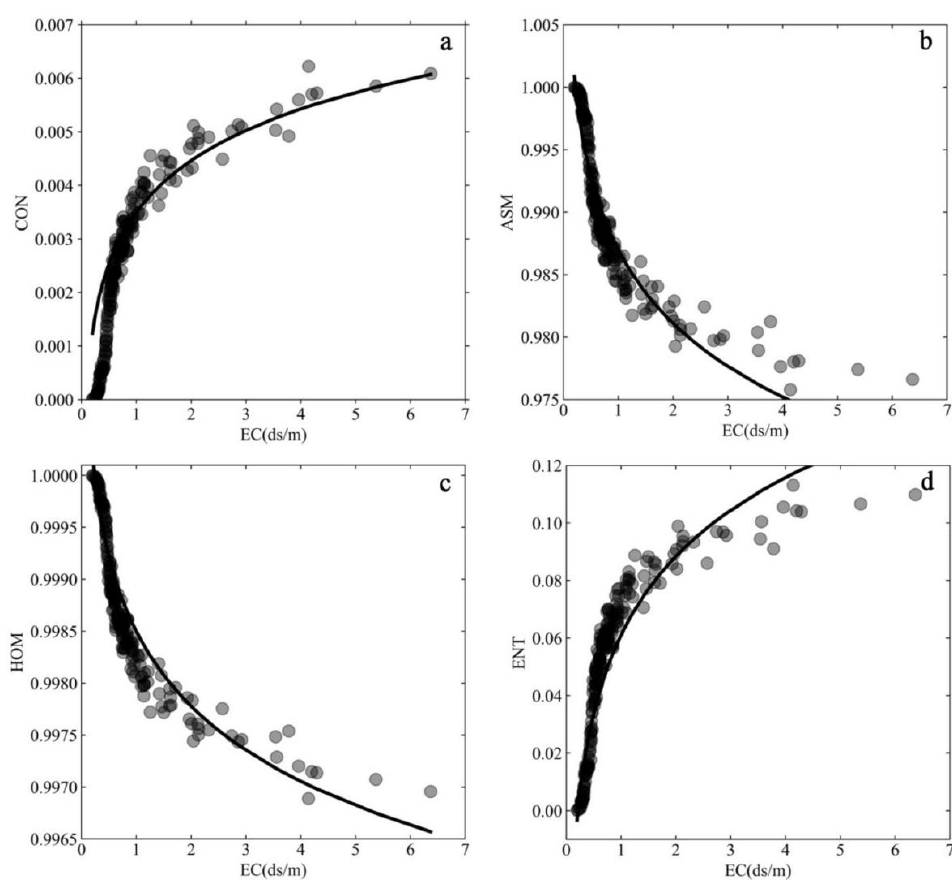
Figure 9. Logarithmic fitting results between EC and four GLCM texture features of the cracked soil samples. ( a ) between EC and CON; ( b ) between EC and ASM; ( c ) between EC and HOM; ( d ) between EC and ENT.